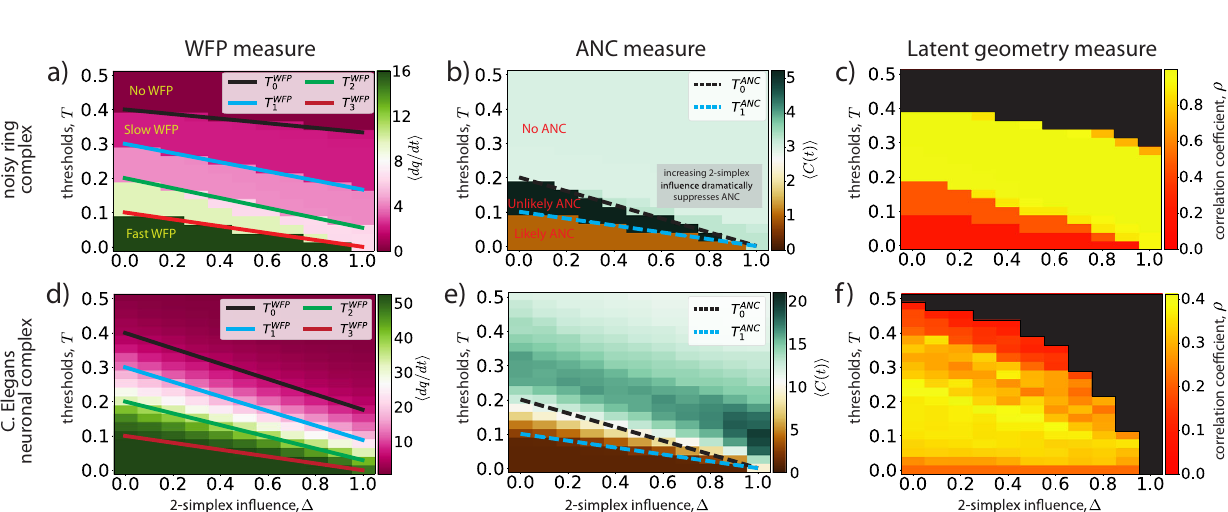
Fig. 6 Empirical measurements for wavefront propagation and new cluster appearance rates predicted by critical thresholds. We study 2D simplicial threshold model (STM) cascades with various T and Δ over (top row) a noisy ring complex with N = 1000 vertices, d ( G ) = 8, and d ( NG ) = 2 and (bottom row) the C. elegans neuronal complex. a An empirical measure for wavefront propagation (WFP) speed, dq , which we compute at t = 5 and average across all initial dt conditions with cluster seeding. Observe that dq undergoes changes at the critical thresholds T WFP given by Eq. (3), which vary with Δ . Within each region j dt ; T WFP T 2 ½ T WFP Þ , observe that the growth rate is close to our predicted rate of 2 j + 2. b An empirical measure for appearance of new clusters (ANC), C ( t ), j þ 1 j which we compute at t = 5 and average across initial conditions. Observe that C ( t ) undergoes changes that are accurately predicted by critical thresholds T ANC j ; T ANC given in Eq. (4). That is, there are three regions T 2 ½ T ANC Þ , and ANC events occur at approximately the same rate within each region. c A Pearson j þ 1 j correlation coef fi cient ρ quanti fi es the extent to which STM cascades predominantly follow along the manifold via WFP. It is computed by comparing pairwise- distances between vertices v i to v i 0 in the original 2D ambient space containing the ring manifold to pairwise-distances ∣∣ τ ( i ) − τ ( j ) ∣∣ 2 between a